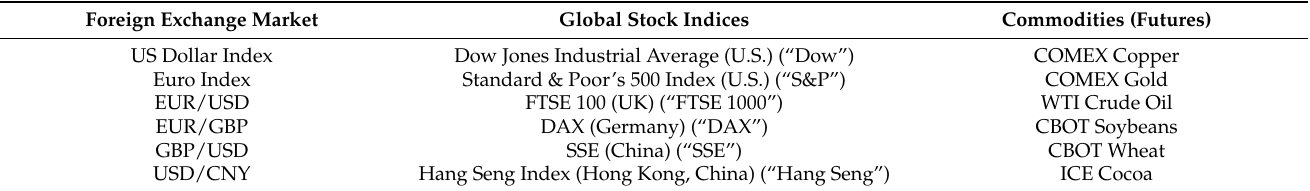
Table 1. Study data.